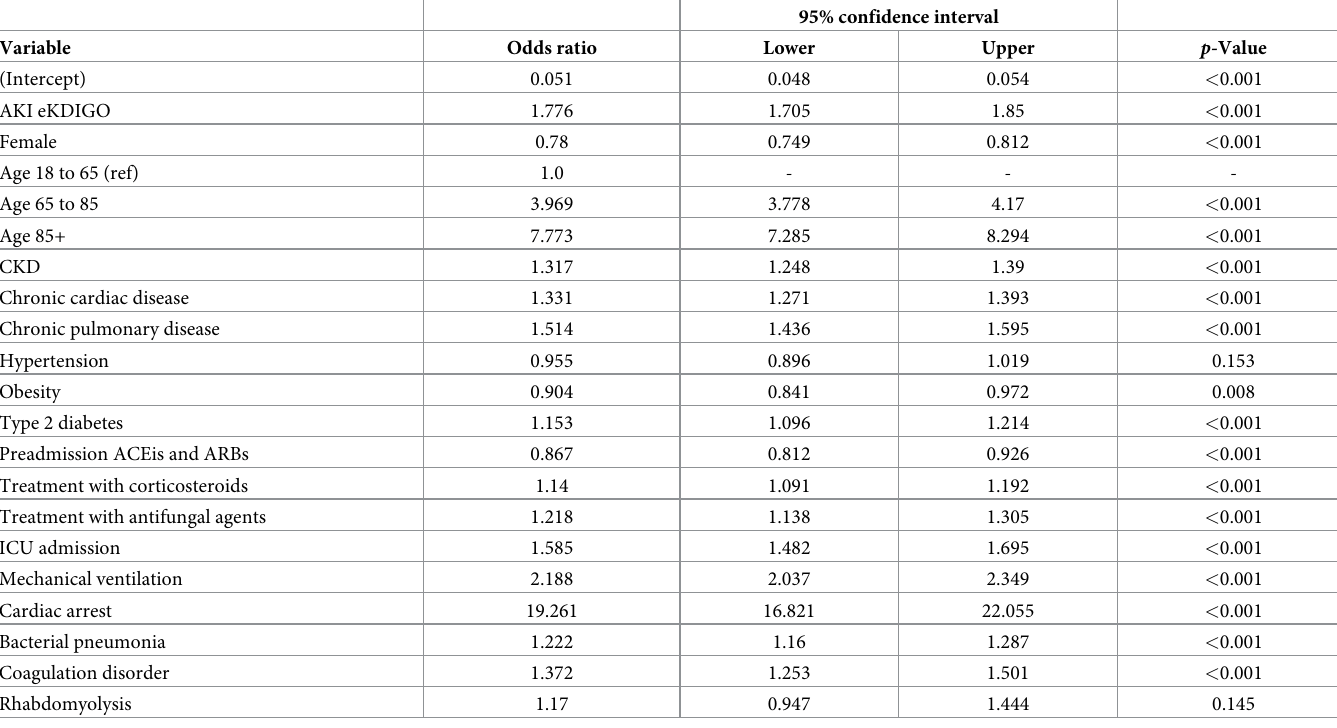
Table 5. Logistic regression fitted to assess the association between eKDIGO AKI with in-hospital